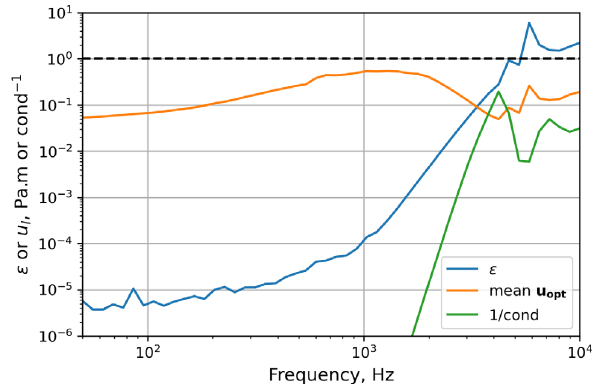
Figure 6. Reproduction error e in the target plane xy , the inverse of condition number of the matrix G and average amplitude of the sources for the con fi guration shown in Figure